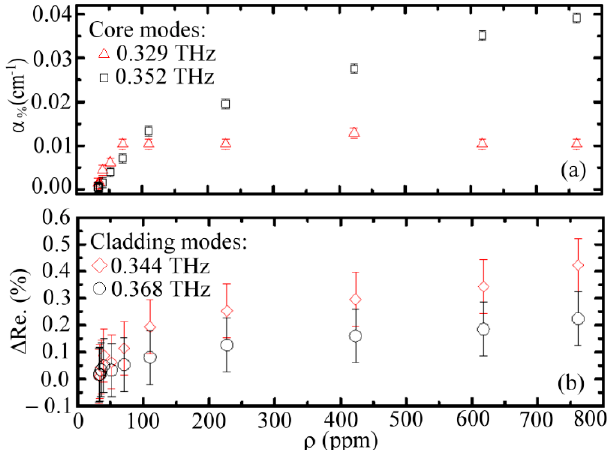
Figure 4. ( a ) Loss coefficients of acetone vapor at core mode frequencies, and ( b ) reflectivity variation ff erent concentrations of acetone vapor of cladding mode frequencies under different concentrations of acetone vapor exposure. of cladding mode frequencies under di